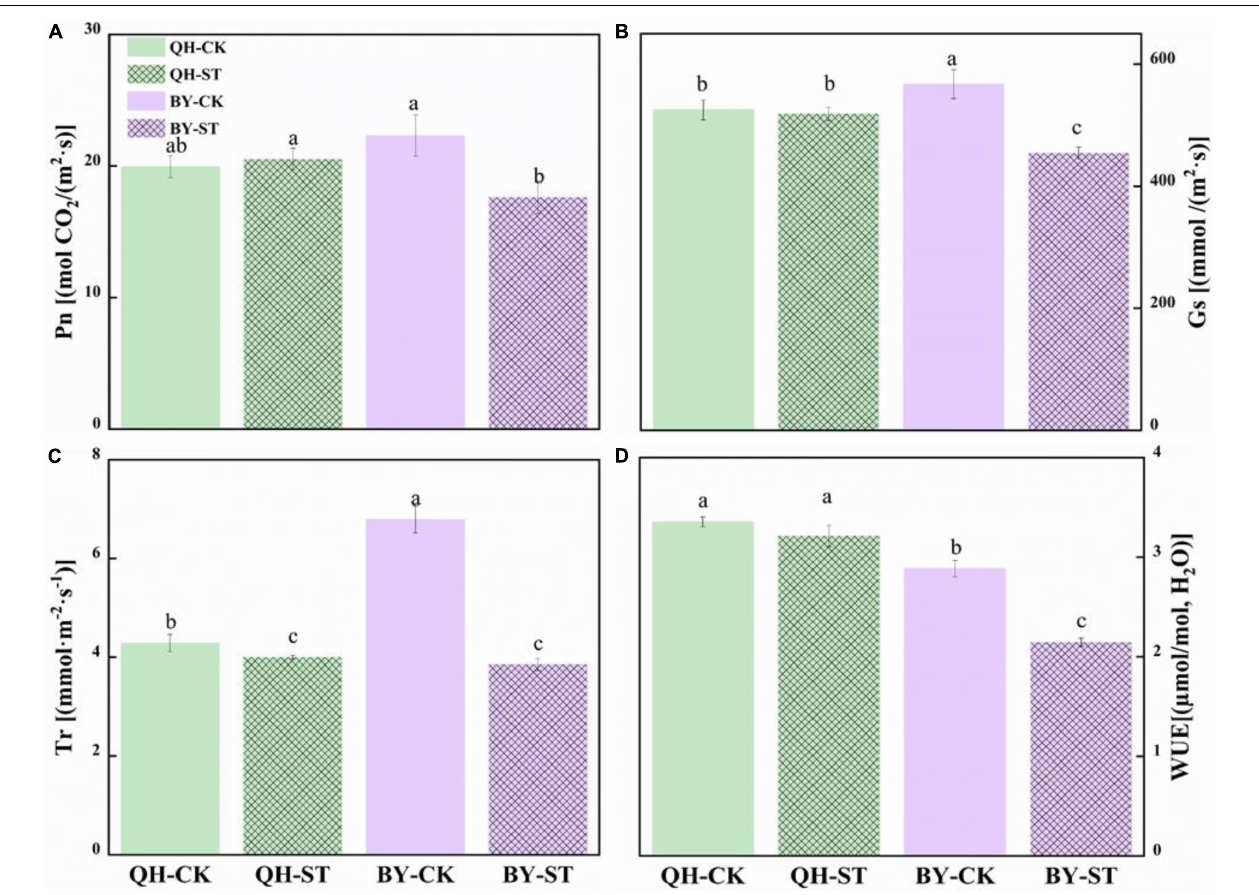
FIGURE 5 | Effect of NaCl on the photosynthetic water vapor parameters of Qinghua45 (QH) and Biyuchunhua (BY). (A) Net photosynthetic rate (Pn), (B) stomatal conductance (Gs), (C) transpiration rate (Tr), and (D) water use efficiency (WUE) of Chinese cabbage under salt stress conditions. Data are the means of three replicates ± SD, and the different letters (a–d) indicate a significant difference at P ≤ 0.05 according to Duncan’s test.